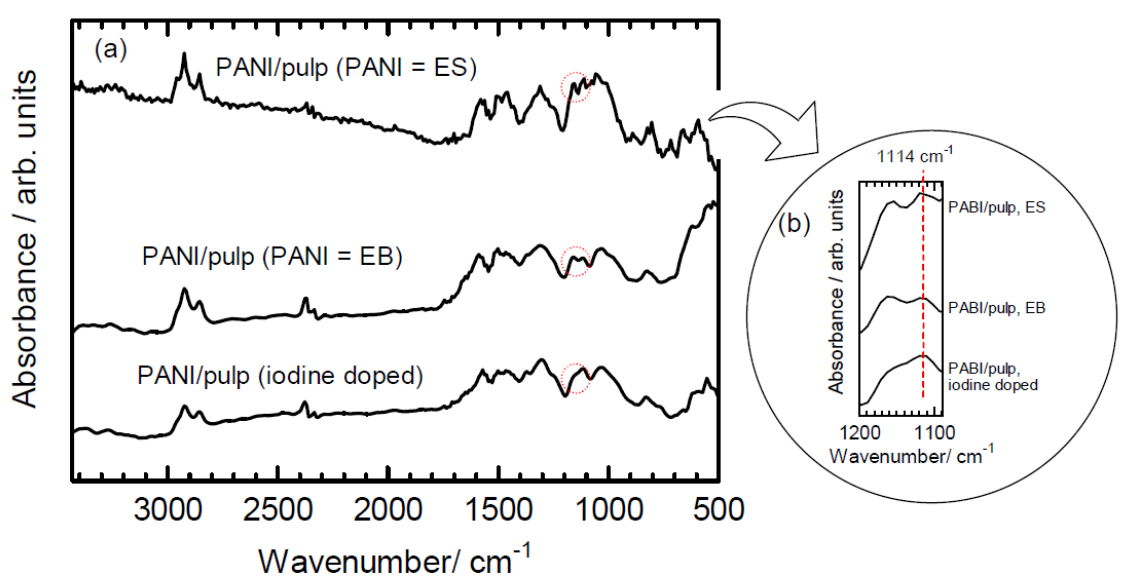
Figure 5. Infra-red (IR) absorption spectra of PANI/pulp (as polymerized, PANI = emeraldine salt (ES)), PANI/pulp (after treatment of ammonia, PANI = emeraldine base (EB)), and iodine-doped PANI/pulp ( a ). Magnification of the spectra at low wavenumbers ( b